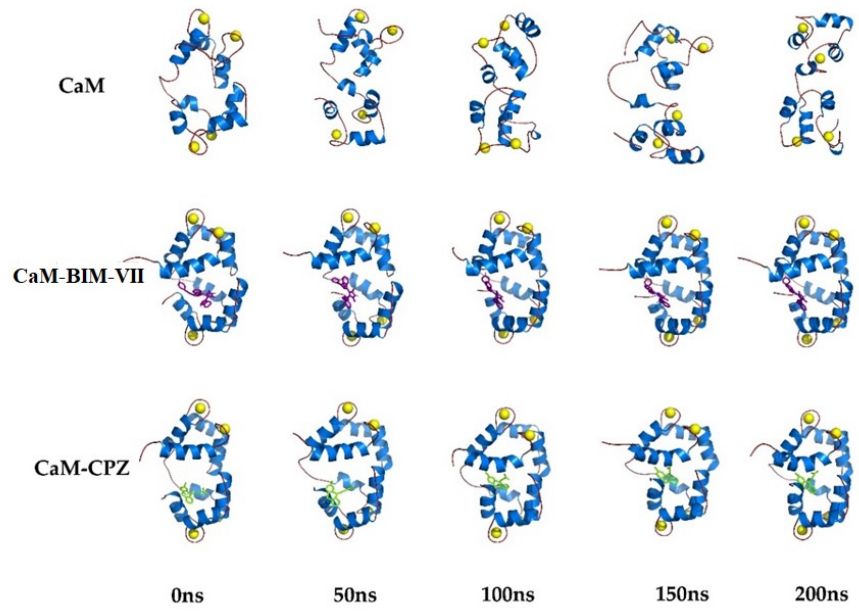
Figure 7. Structural models of molecular dynamics simulation of Ca 2+ -CaM and Ca 2+ -CaM-BIS-VII and, Ca 2+ -CaM-CPZ complexes (200 ns).